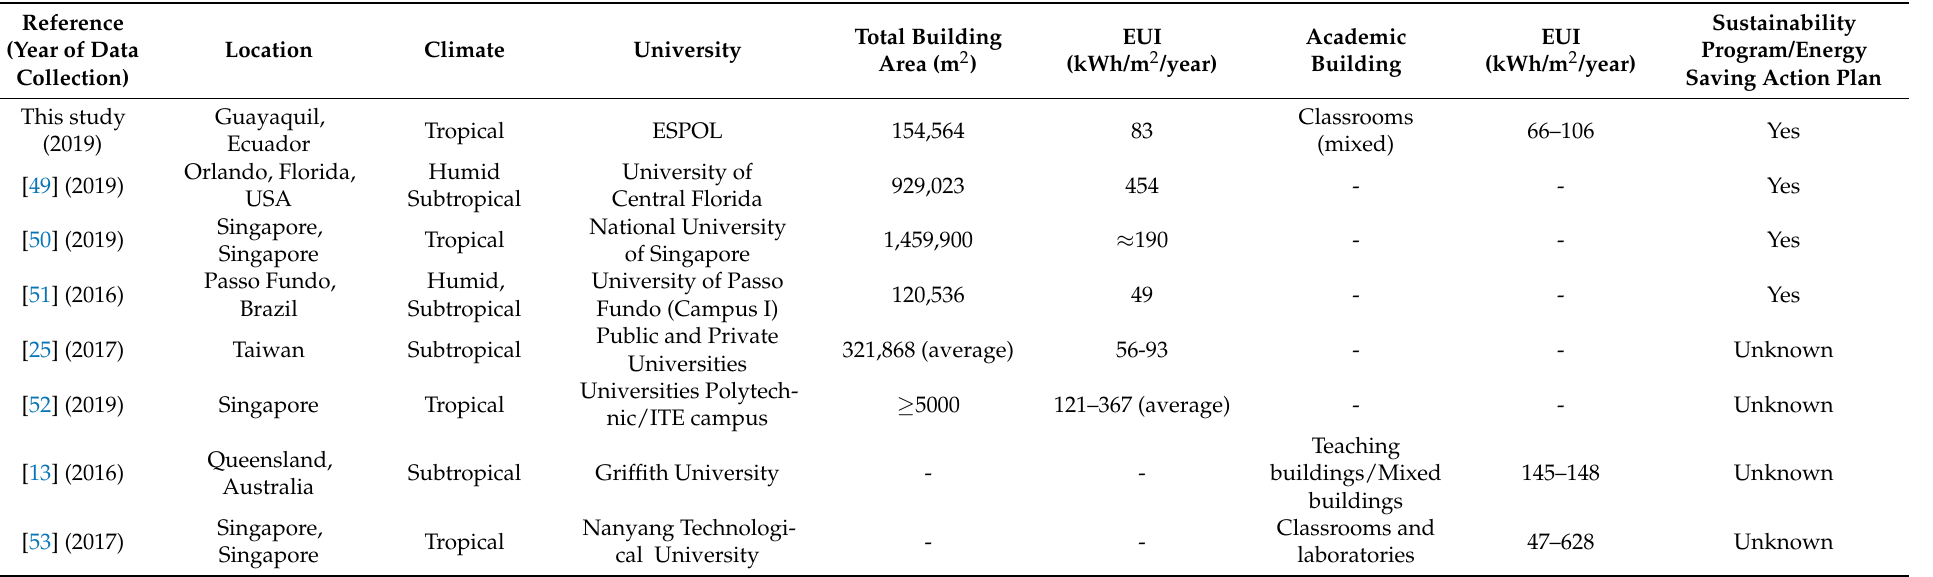
Table 8. Summary of some EUIs reported in the literature for university campuses and academic